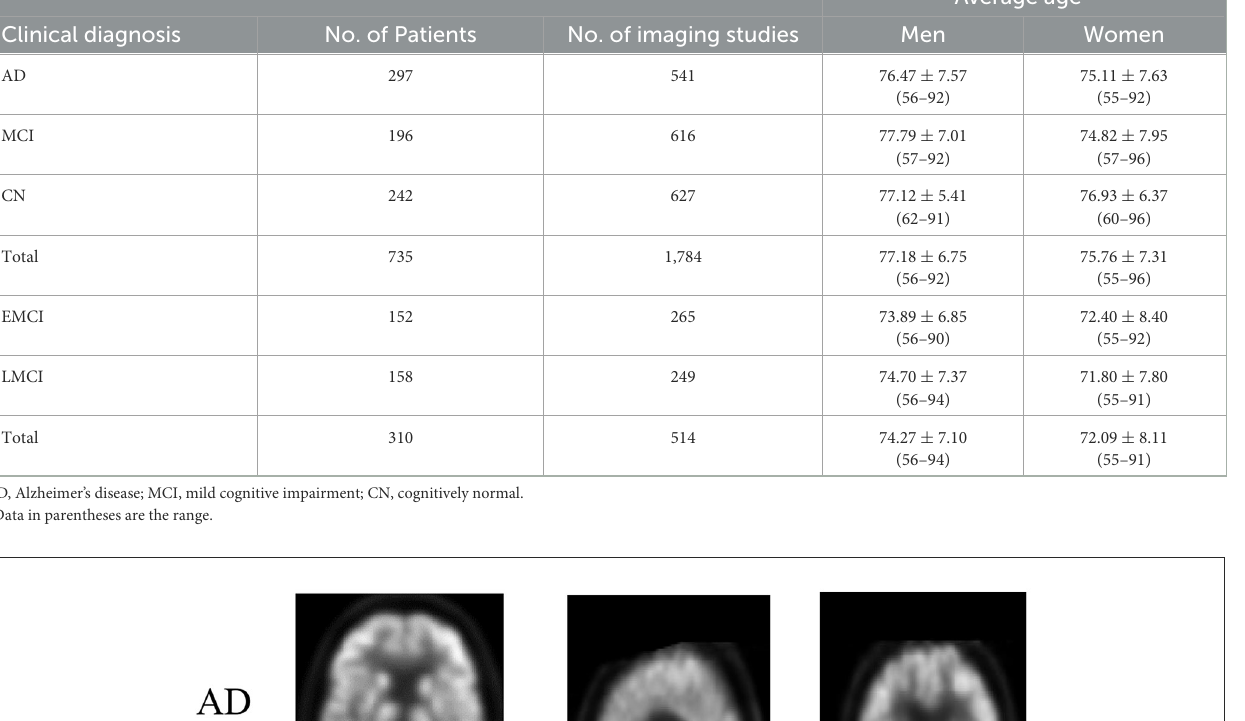
network (RVFLLNN) (Pao and Takefuji, 1992; Chu et al., 2019; Gong et al., 2021). It can obtain a globally optimal solution using a ridge regression algorithm during training. without